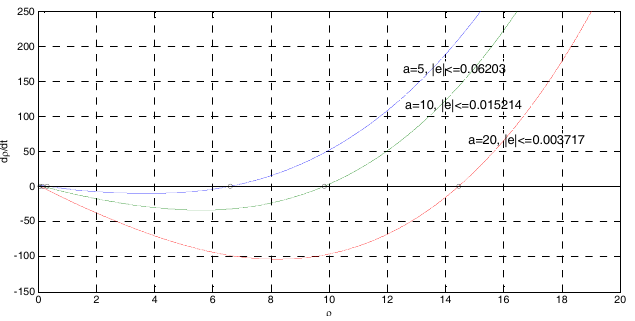
Figure 37. Majorant systems for